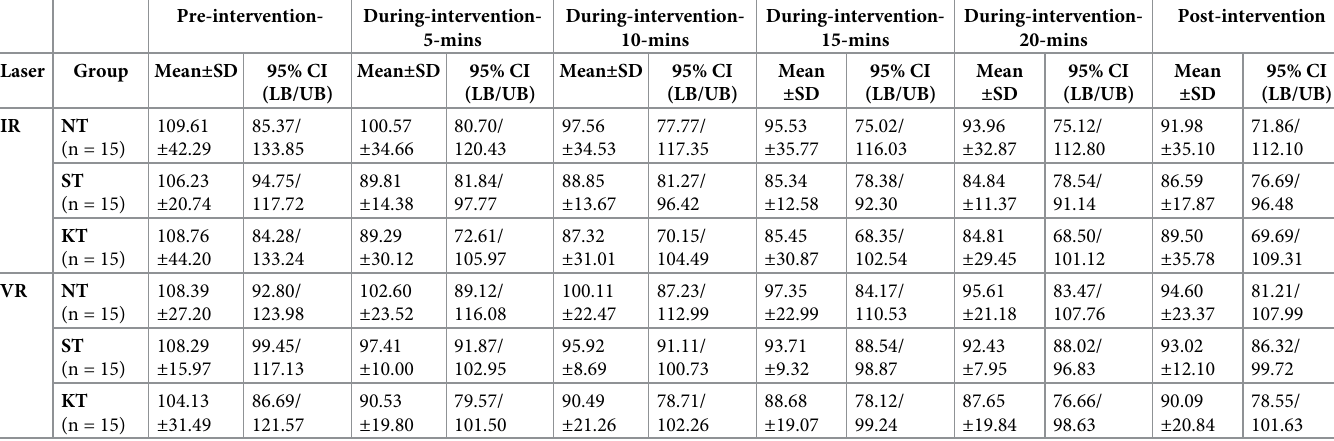
Table 2. Group x Time mean counts of blood perfusion of infrared (IR) and visible-red (VR) data.